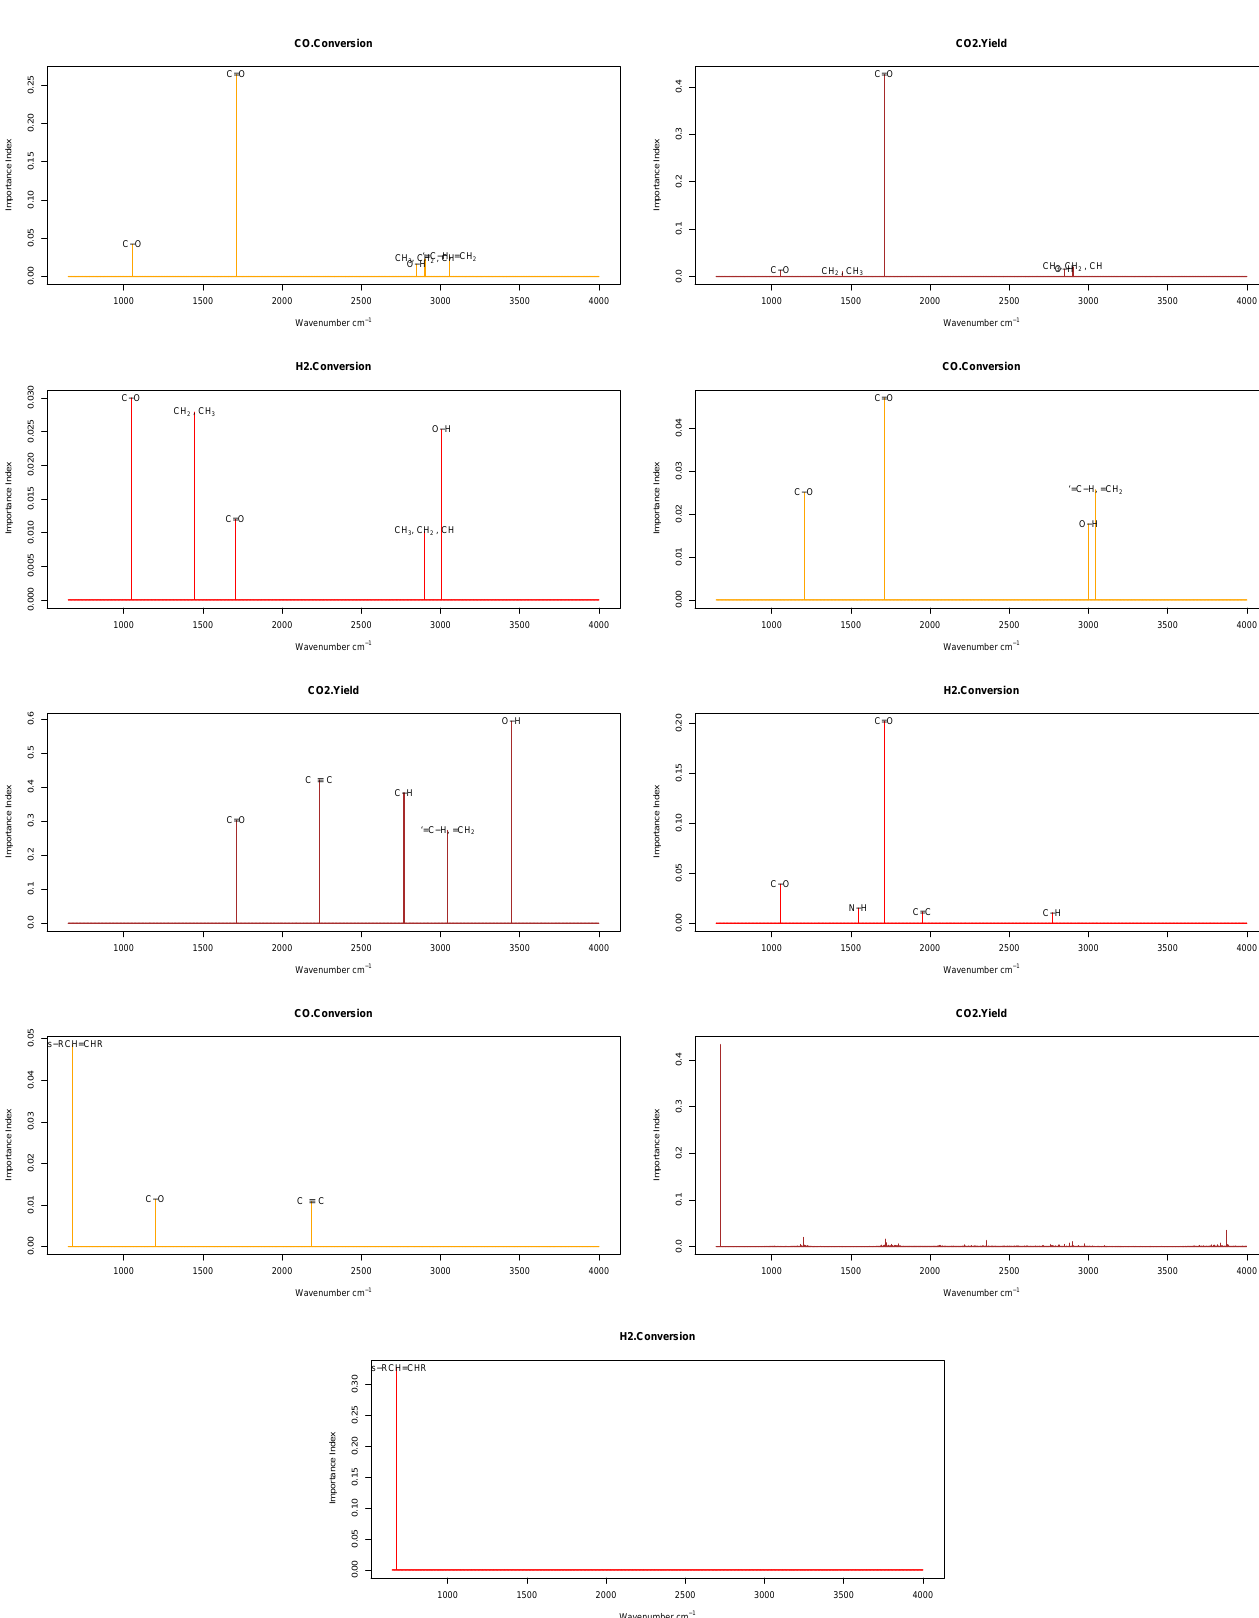
Figure 6. The best model for each ESR product prediction is then used to identify the influential wavenumbers. The influen- tial wavenumbers were further mapped to functional compounds for each optimal model. The influential wavenumbers indicate the intensity of their selection, and the corresponding functional compound is